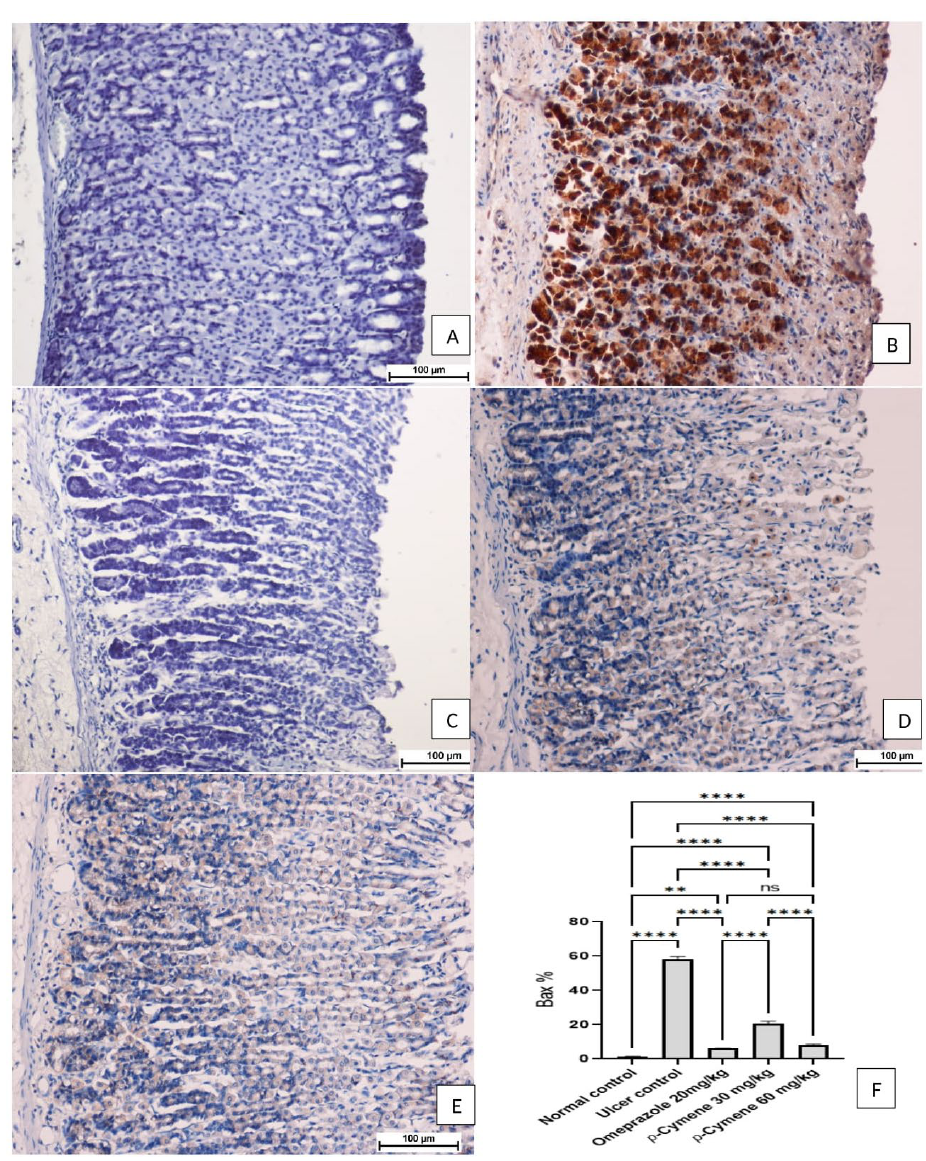
Figure 7. Effects of p-Cymene on microscopical observation of Bax protein expression ( A – E ) and quantitative analysis ( F ) of Bax protein expression of the gastric mucosa in ethanol-induced gastric ulcers in rats. Normal control group displayed normal gastric mucosal structure and very weak expression of Bax protein in the gastric mucosa ( A , F ). Ulcer control group presented severe damage of the gastric mucosa and up-regulation of Bax protein expression in ethanol-induced gastric ulcers in rats ( B , F ). Omeprazole group exhibited mild damage of the gastric mucosa and down-regulation of Bax protein expression of the gastric mucosa compared to the ulcer control group in etha-nol-induced gastric ulcers in rats ( C , F ). p -Cymene group given 30 mg/kg showed moderate injury of the gastric mucosa and down-regulation of Bax protein expression of the gastric mucosa compared to the ulcer control group in ethanol-induced gastric ulcers in rats ( D , F ). p -Cymene group given 60 mg/kg displayed mild damage of the gastric mucosa and down-regulation of Bax protein expression of the gastric mucosa compared to the ulcer control group in ethanol-induced gastric ulcers in rats ( E , F ). (Bax stain, magnification 20 × ). The data are presented as means ± SED. The antigen site ap-pears as a brown color. There was significant (****) differentiation between experimental groups in HSP 70% protein expressions with the highest expressions recorded for the B rat group. ns, non-significant; ** p < 0.001; **** p <